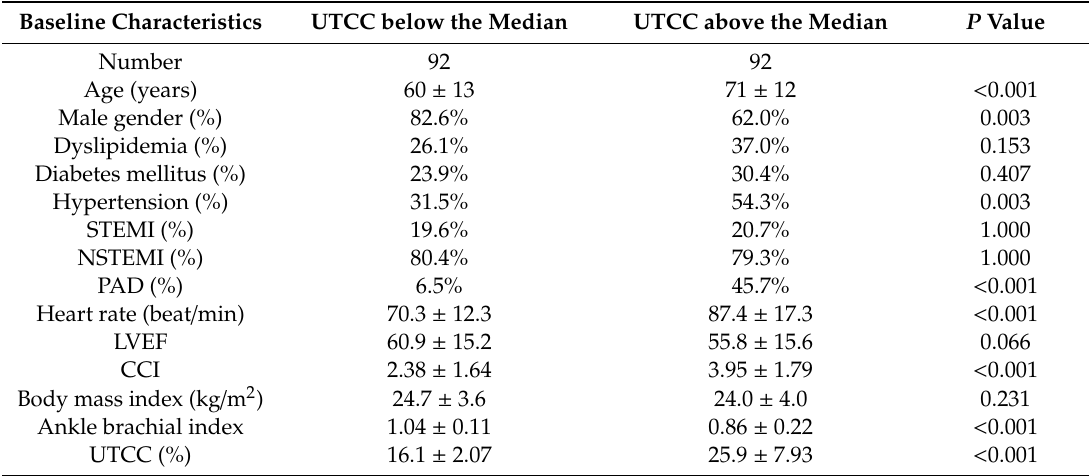
Table 1. Baseline characteristics of the study population classified by upstroke time per cardiac cycle (UTCC) below and above the median